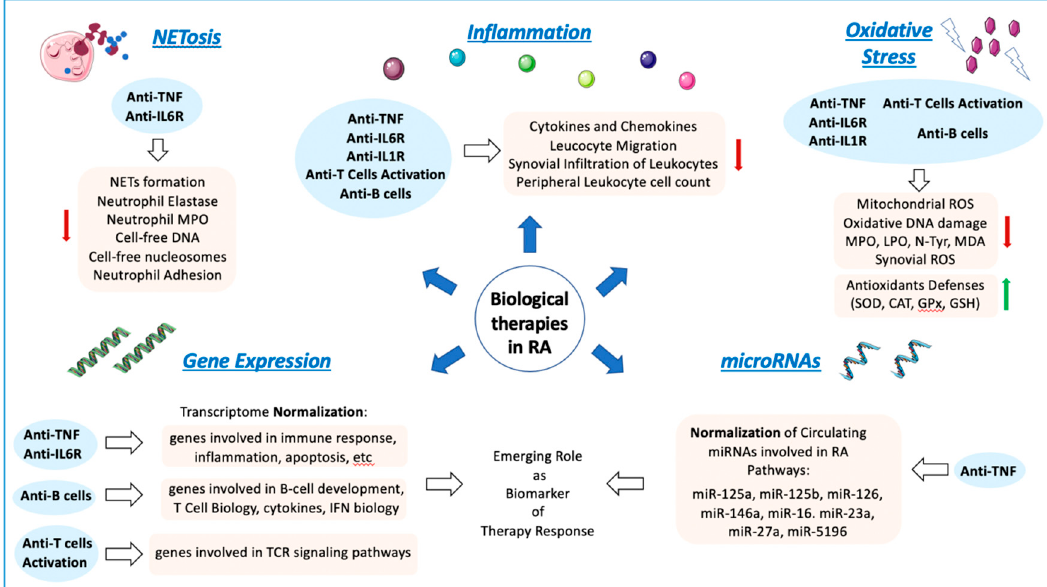
Figure 3. Molecular E ff ects of Biological therapies in RA patients. Biological therapies in RA have shown a wide range of beneficial molecular e ff ects, by controlling numerous mechanisms altered in the disease. Hence, several therapies reduced the protein levels of circulating inflammatory mediators as well as the migration rate of activated immune cells to joints. Oxidative stress and NETosis have been also ameliorated after biological therapies including the reduction of ROS and oxidative markers, and the increase of the antioxidant defenses as well as the decrease of the NETs formation by neutrophils and related derived products. The altered transcriptome profile in peripheral blood and synovium of RA patients has been found normalized after biologics drugs, on which genes involved in key molecular pathways associated with the disease were modulated. Levels of microRNAs controlling the expression of central inflammatory genes have been found modulated in peripheral blood, plasma, and synovial fluid after anti-TNF therapy and some of, them along with mRNAs, are emerging as potential biomarkers predictors of therapy